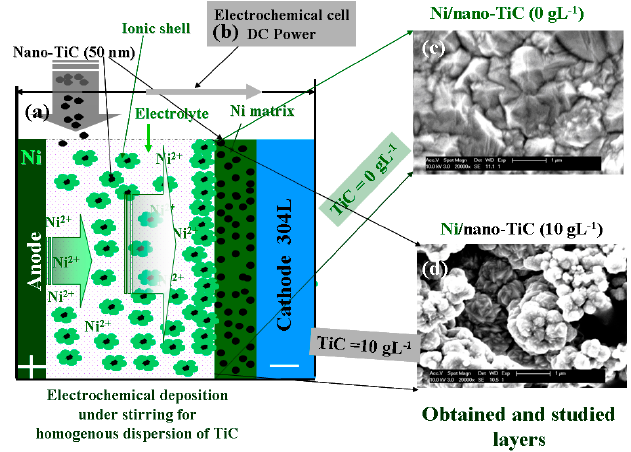
Figure 10. Schematic of the electro-codeposition process used to obtain Ni/nano-TiC nanocomposite layers: ( a ) electrochemical cell; ( b ) electrochemical workstation; ( c ) SEM surface micrograph of pure Ni layer; ( d ) SEM surface micrograph of Ni/nano-TiC layer. A solid nickel plate with an active surface area of about 50 cm 2 was used as a counter